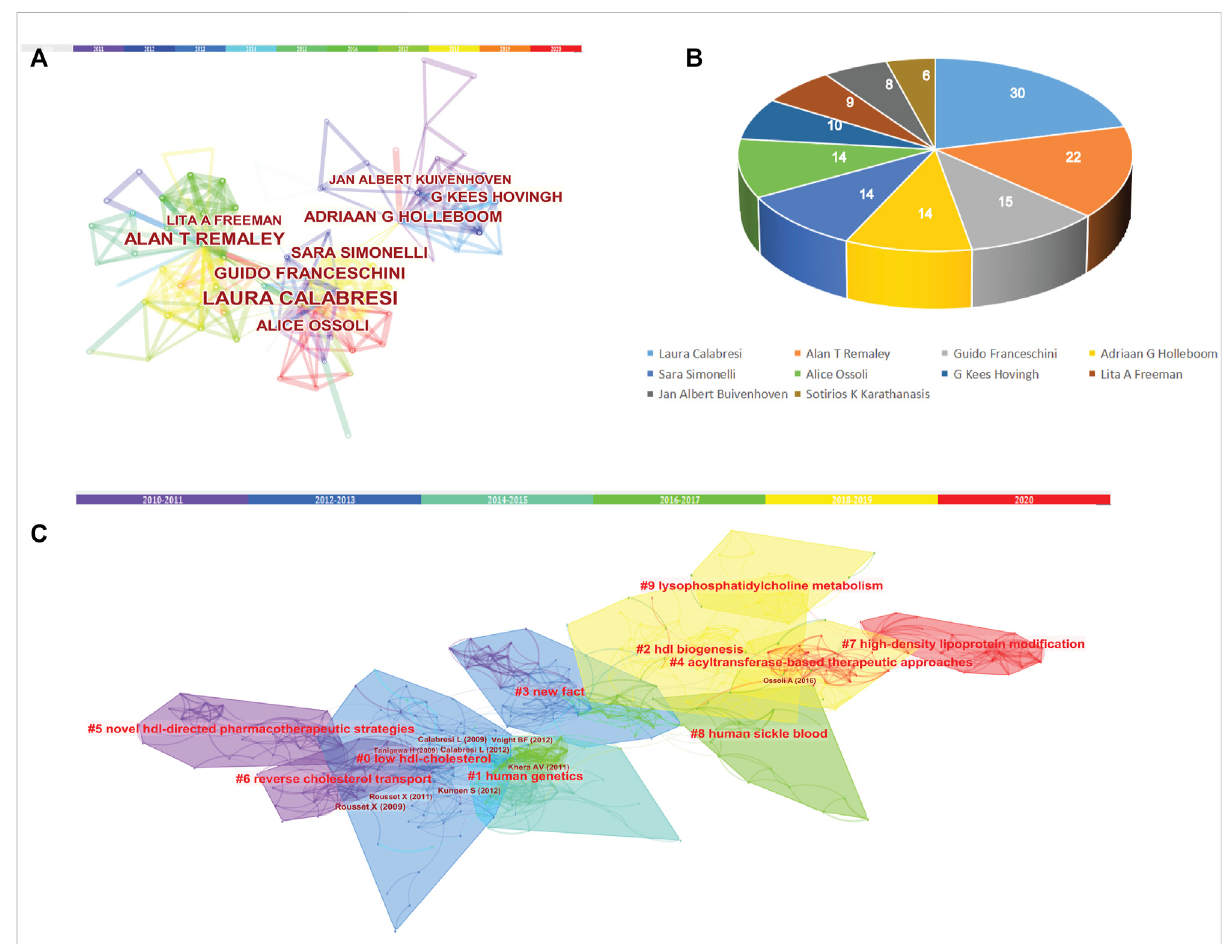
FIGURE 8 Co-authorshipandCitedReferenceCo-citationanalysisinthelast10 years. (A) Co-authorshipofLCAT-relatedstudies. (B) Authorswiththetop 10 number of LCAT-related studies. (C) The network of co-cited references clusters in the last 10